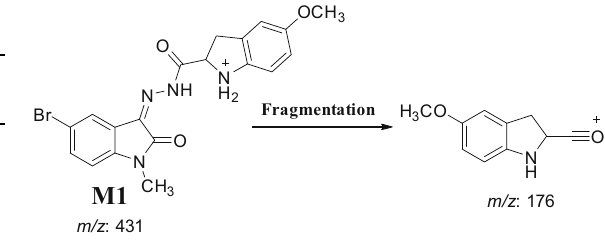
Table 2: Compound 1 and its related possible